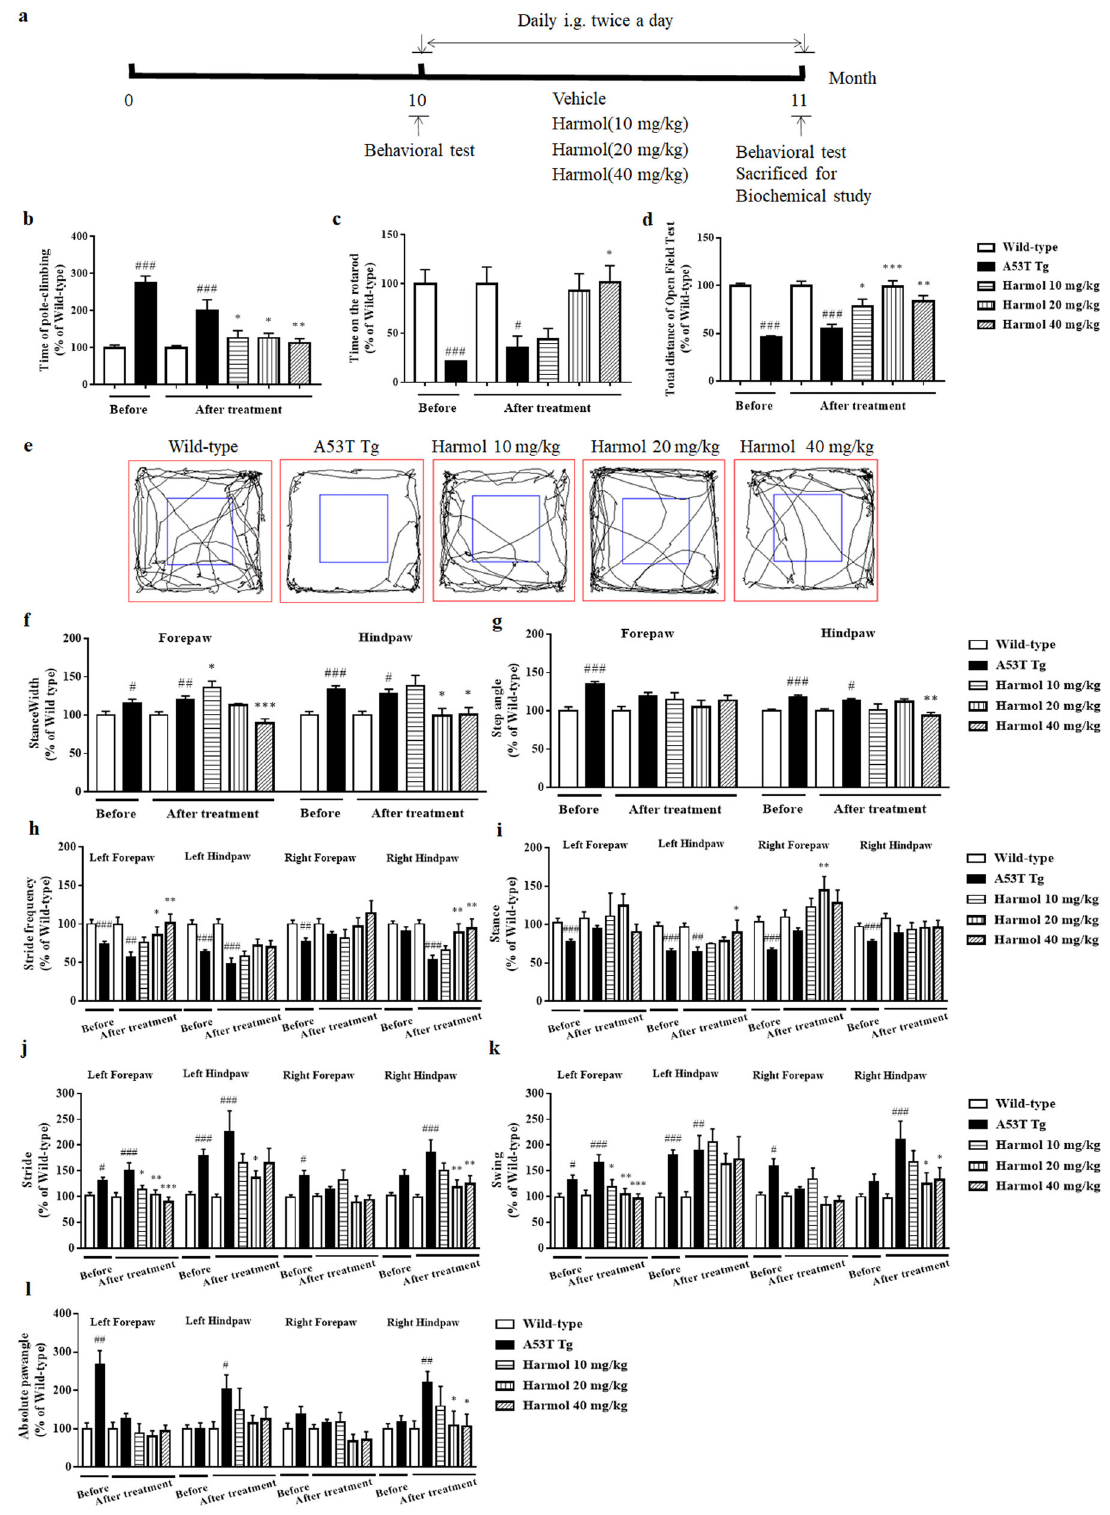
Fig. 5 Harmol rescues behavioral de fi cits in A53T α -syn mice. a Experimental protocol for A53T α -syn mice. b Pole test. Quanti fi cation of the pole-climbing time for each treatment (mean ± SEM). ### P < 0.001 vs. the wild-type (saline). * P < 0.05 and ** P < 0.01 vs. the A53T Tg. c Rotarod test. Quanti fi cation of the latency time on the rotarod for each treatment (mean ± SEM). # P < 0.05 and ### P < 0.001 vs. the wild-type (saline). * P < 0.05 vs. the A53T Tg. d Open- fi eld test. Quanti fi cation of the total distance traveled in the open- fi eld test for each treatment (mean ± SEM). ### P < 0.001 vs. the wild-type (saline). * P < 0.05, ** P < 0.01, and *** P < 0.001 vs. the A53T Tg. e Representative exploratory patterns of mice in each group. f – l Automated treadmill gait test. Quanti fi cation of the stance width ( f ), step angle ( g ), stride frequency ( h ), stance ( i ), stride ( j ), swing ( k ), and absolute paw angle ( l ) for each treatment (mean ± SEM). # P < 0.05, ## P < 0.01 and ### P < 0.001 vs. the wild-type (saline). * P < 0.05, ** P < 0.01 and *** P < 0.001 vs. the A53T